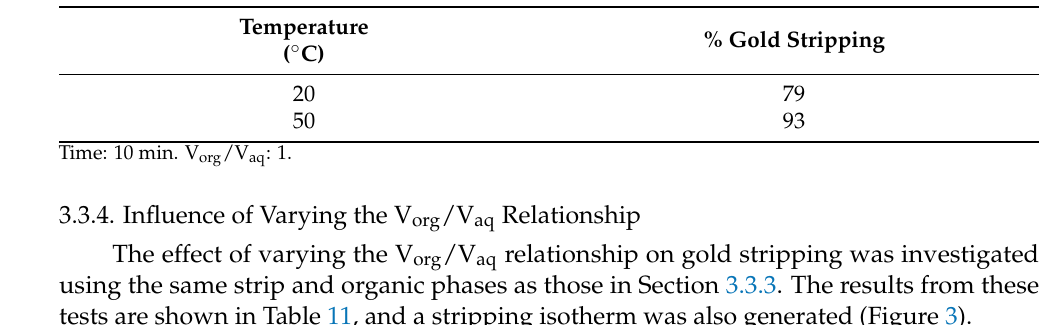
Table 10. Influence of temperature on gold stripping.